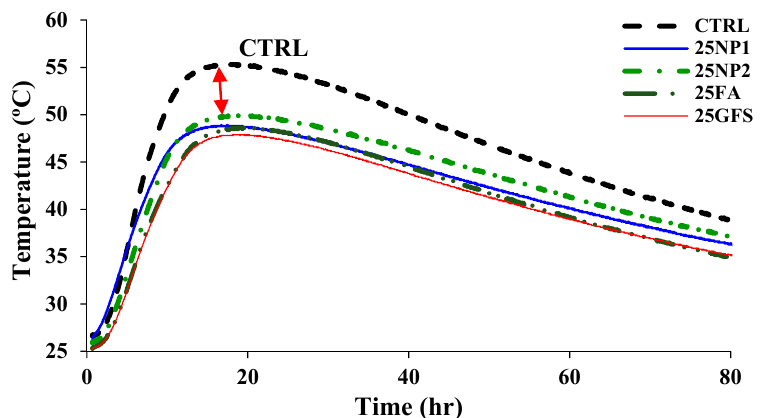
Figure 18. Concrete core temperature of concrete mixes compared to control mix (CTRL) .